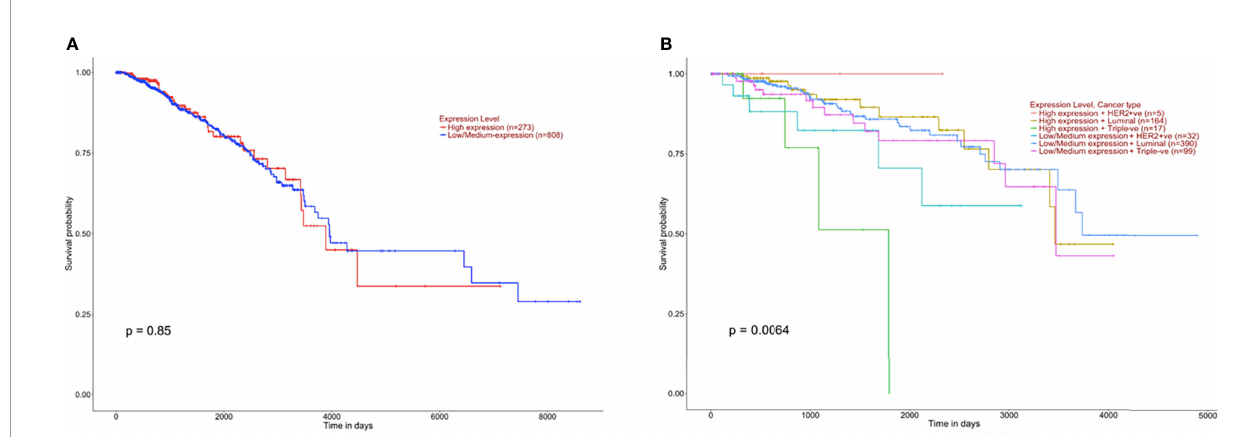
FIGURE 2 | Kaplan Meier survival graphs of breast cancer patients based on GPR68 expression using UALCAN in-silico tool. (A) Survival plot of breast cancer patients that are classi fi ed according to high and low GPR68 expression showing that it is not a prognostic factor. (B) Classi fi cation of breast cancer patients with low and high GPR68 expression as well as molecular subtypes (Her2-enriched, luminal and triple-negative) showed GPR68 to be a potential marker affecting the survival of breast cancer patients.